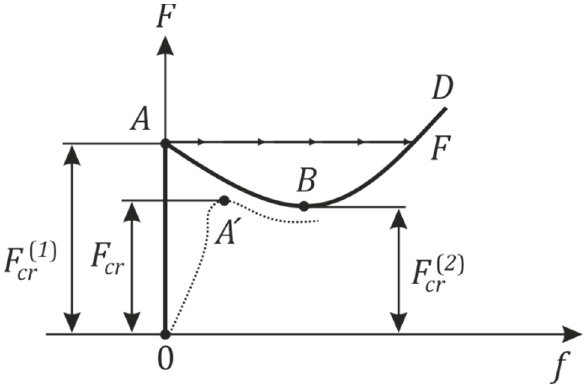
Figure 1. The shell element diagram for loss of